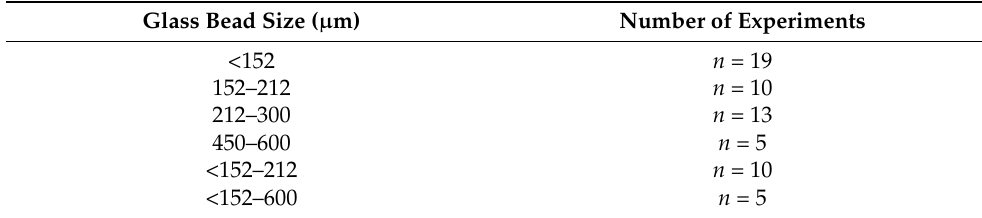
Table 1. Mixtures of 30% sugar water with various glass bead sizes (Sigma, glass beads,